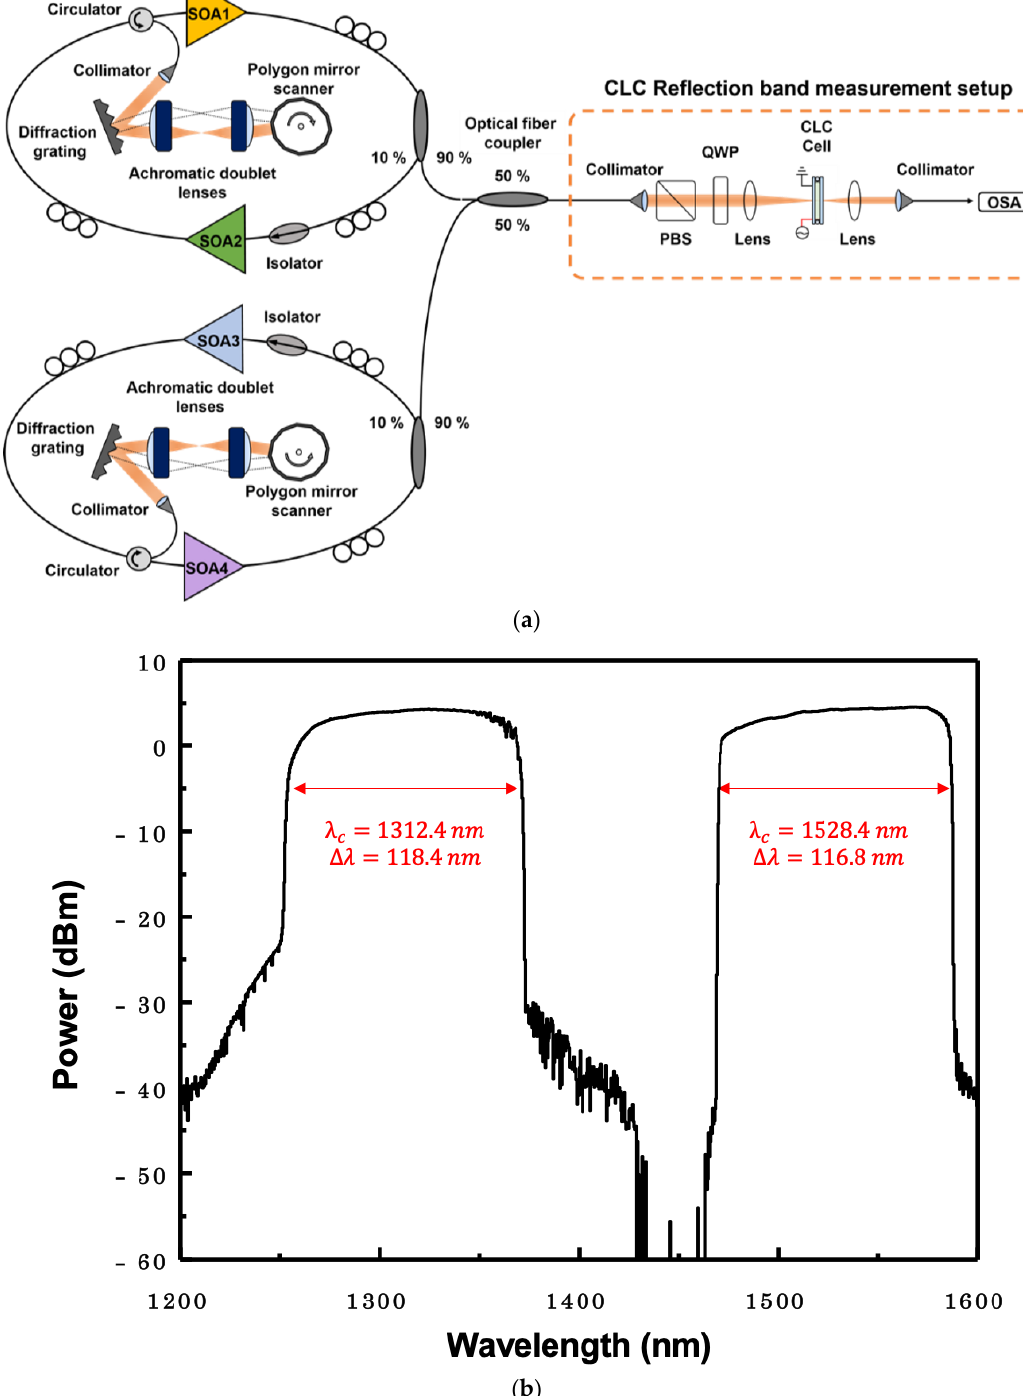
Figure 5. ( a ) Experimental setup for measuring the CLC reflection band and ( b ) optical spectrum output from the WSL.